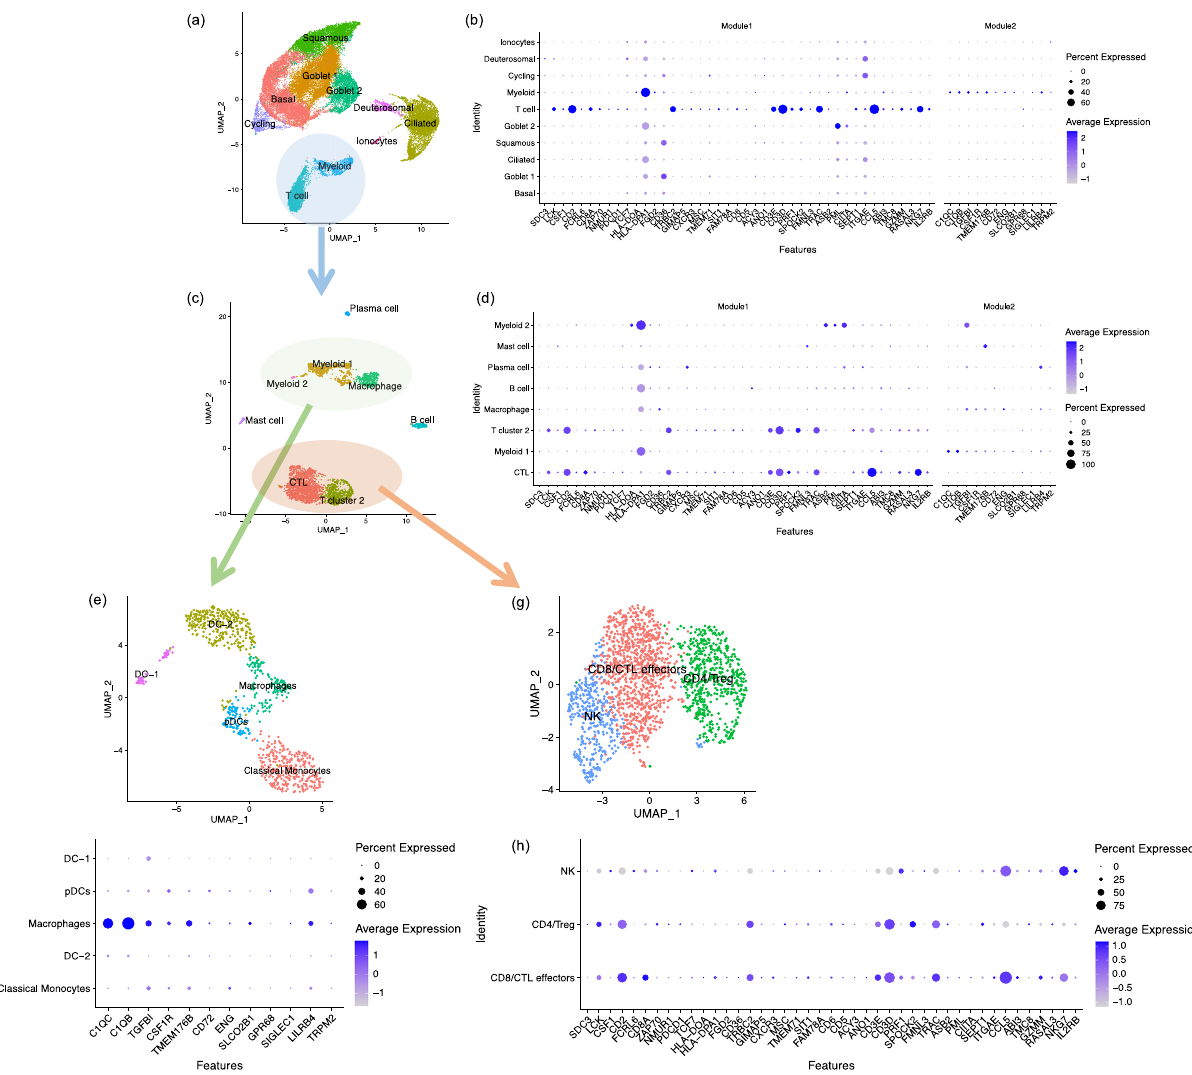
Fig.5|ExpressionpatternsofgenesassociatedwiththreeCpGsitesindifferent celltypes. Usingsingle-celldata,weidenti fi ed ten celltypesinnasalbrushingcells ( a ). We identi fi ed two gene modules from eQTM genes by Weighted Gene Co- expression Network Analysis (WGCNA). Plot ( b ) depicts the average expression levelspercellclusterofgenesfromModule1andModule2,whichwereavailablein the nasal scRNA-seq dataset in all cell types. Genes from Module 1 were highly expressed in the T cell cluster and genes from Module 2 were enriched to myeloid cells. After re-clustering of all immune cells from the two immune clusters, we